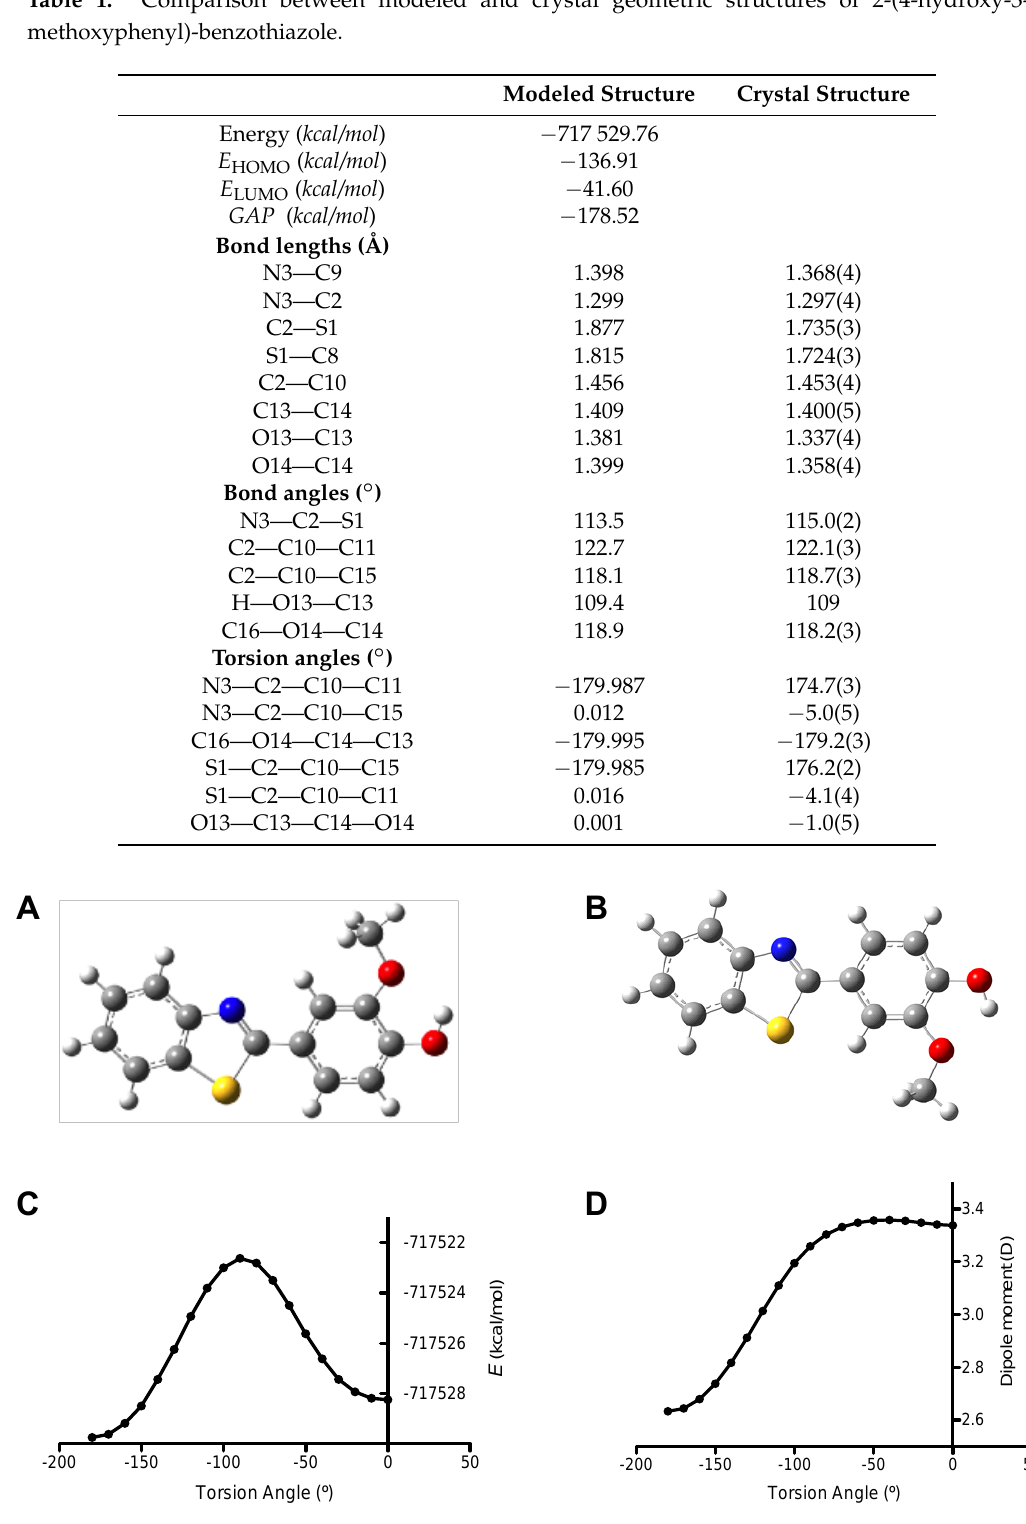
Figure 2. Theoretical calculations for 4-(1,3-benzothiazol-2-yl)-2-methoxyphenol. Molecular structure of: ( A ) syn -rotamer and ( B ) anti -rotamer; ( C ) rotational barrier plot and ( D ) dipolar moment plot, both depending on the torsion angle of N3-C2-C10-C11.